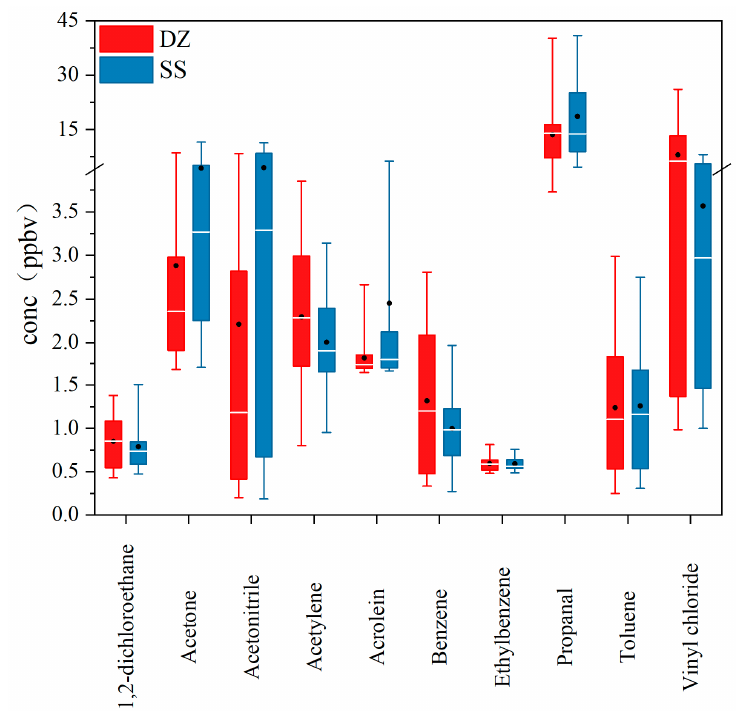
Figure 3. Comparison of VOC concentrations at DongZhang community (DZ) and Special School (SS) sites. The upper and lower bars indicate the maximum and minimum values. Lines inside boxes show the median value, and black dots show the mean values.